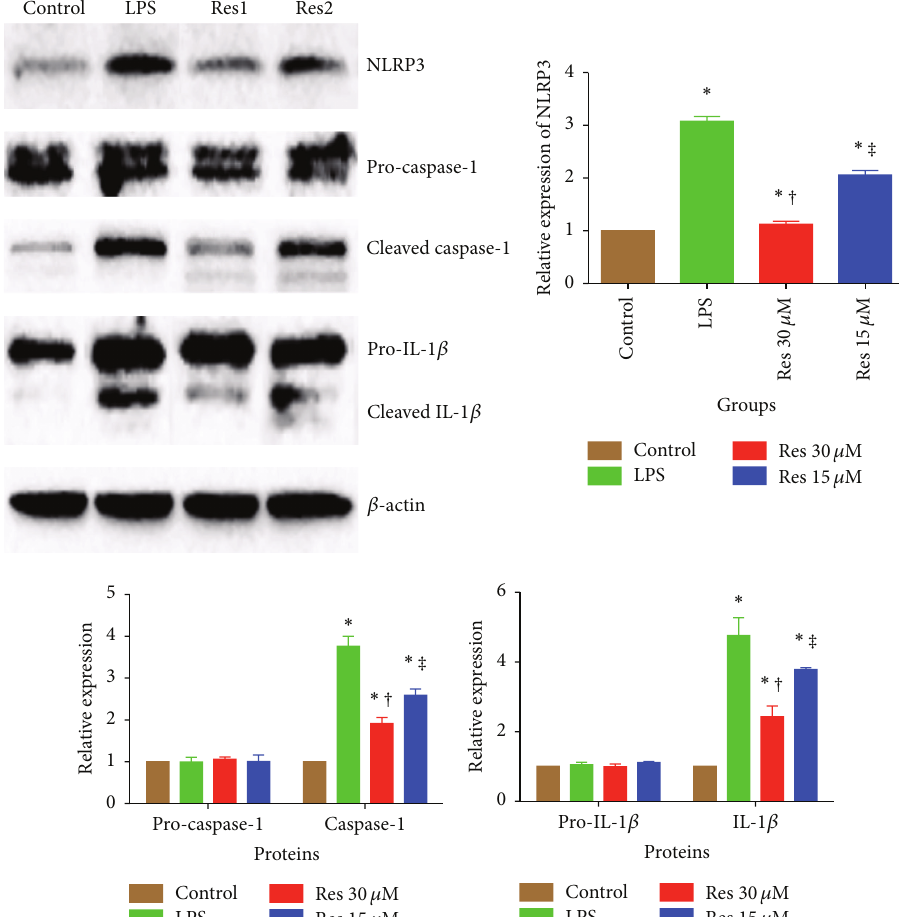
Figure 5: In vitro assay of the inhibitory effect of resveratrol on inflammasome activation in BV2 cells. BV2 immunoblots of NLRP3, caspase- 1 and IL-1 𝛽 , in the presence and absence of resveratrol. All blots have been normalized to 𝛽 -actin. Control cells were stimulated with ATP (100 𝜇 M) alone, while LPS cells were stimulated with both ATP and LPS (100ng/mL). Res1 cells were treated with higher dose of resveratrol (30 𝜇 M), in the presence of ATP and LPS. Res2 cells were treated with lower dose of resveratrol (15 𝜇 M), in the presence of both ATP and LPS. ∗ 𝑃 < 0.05 compared with control group, † 𝑃 < 0.05 compared with LPS group, and ‡ 𝑃 < 0.05 compared with Res1 group, by one-way ANOVA and LSD tests. Bars represent the mean ±